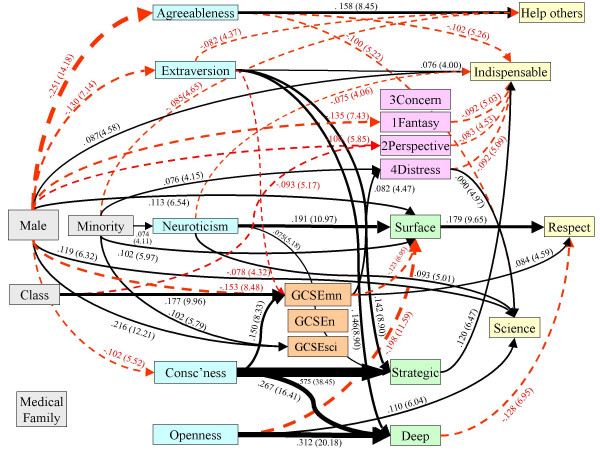
Path diagram showing the relationships between the different variables. Paths are only included for which t ≥ 4.0. Positive paths are shown as solid black lines, and negative paths as dashed red lines, with path coefficients (path coefficient; t) shown in black or red respectively. The thickness of lines is proportional to the size of the path coefficient. Only causal relationships from the B (beta) matrix are shown, and can only pass from left to right. Clusters of variables regarded as causally equivalent are shown in the same colour, and in general are vertically above one another, although on some occasions they have been moved slightly to one side or other to make the diagram clearer. Associations between causally equivalent variables are modelled in the Φ (phi) matrix, which is saturated within vertical groups and zero elsewhere, and are not shown here (and that in particular explains the apparent absence of a link between being male and being from an ethnic minority). An attempt has been made to avoid lines crossing one another, or lines passing behind variable boxes, but that is not always possible in a diagram of this complexity.